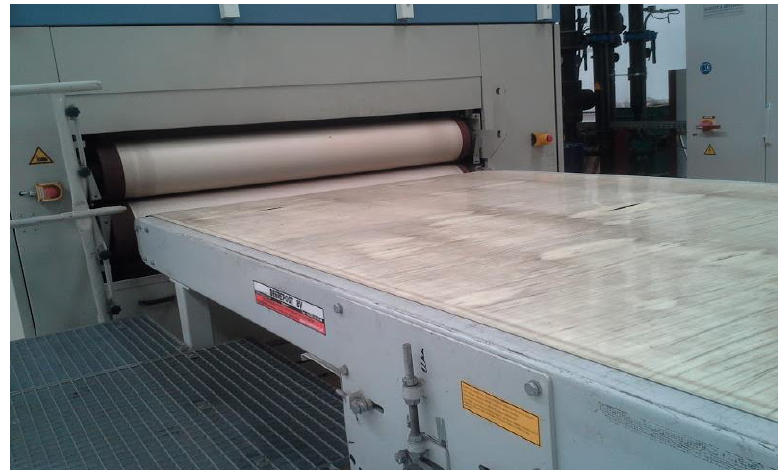
Figure 4. Sandwich panel’s output.